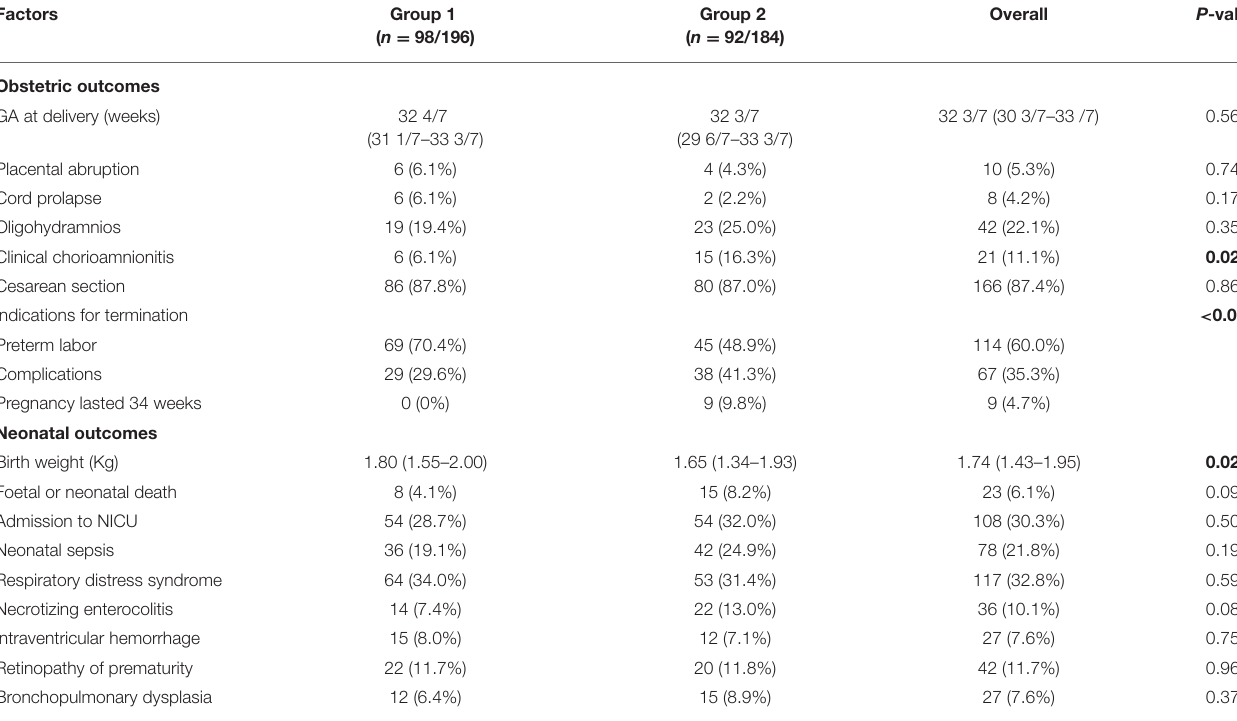
TABLE 3 | Perinatal outcomes associated with PPROM according to latency period.